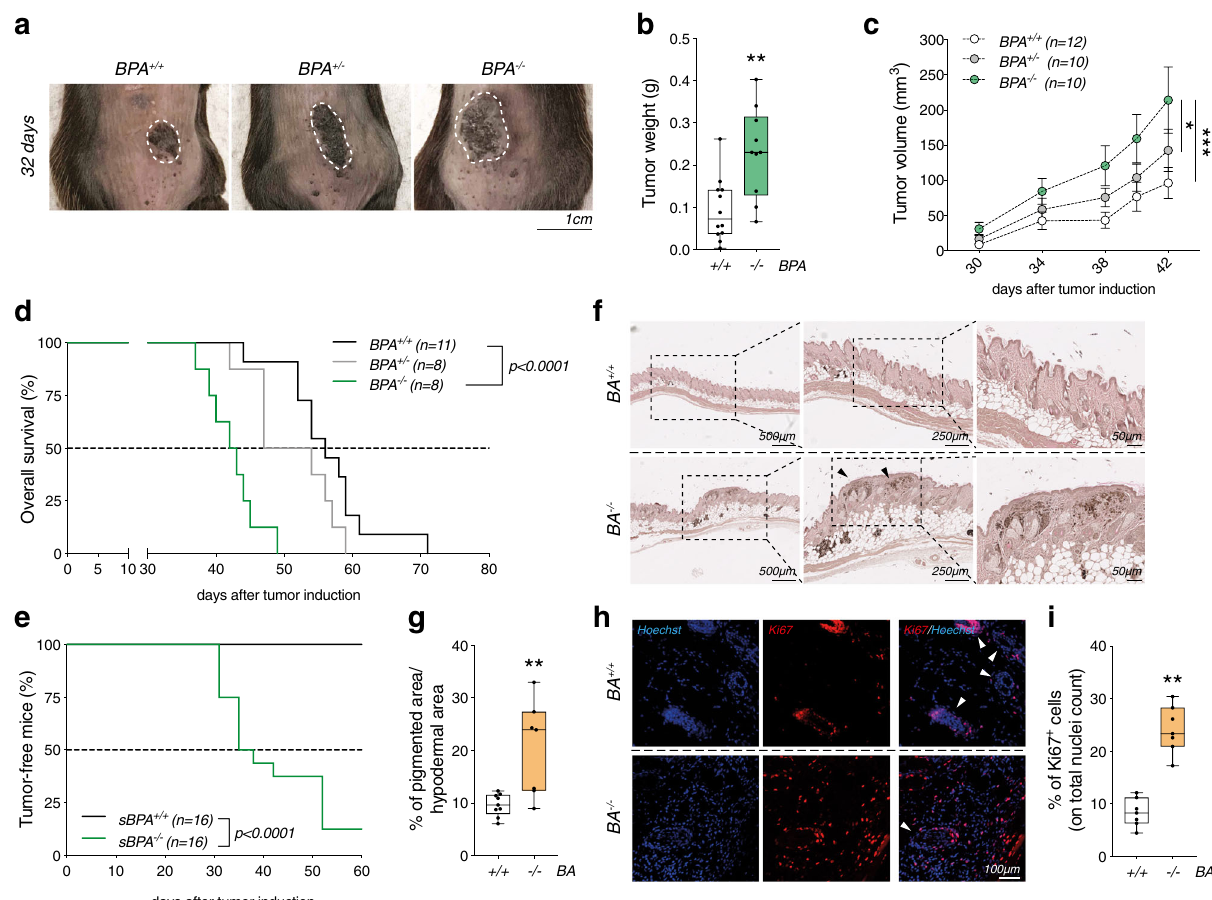
Fig. 1 Ambra1 deletion promotes melanoma development in Braf V600E/ + ;Pten − / − mice. a Representative pictures of tumors from BPA + / + , BPA + / − and BPA − / − mice at 32 days after treatment. b Weight of BPA + / + ( n = 12) and BPA − / − ( n = 10) tumors at endpoint (42 days) (** p = 0.0053, two-tailed unpaired t -test, BPA − / − vs. BPA + / + ). c Kinetics of tumor growth in BPA + / + ( n = 12), BPA + / − ( n = 10) and BPA − / − ( n = 10) mice. Each data point corresponds to the average tumor volume ± SEM for each experimental group ( *p = 0.0128; ***p = 0.001, one-way ANOVA). d Kaplan – Meier overall survival curves of BPA + / + ( n = 11), BPA + / − ( n = 8) and BPA − / − ( n = 8) mice ( p < 0.0001 , Two-sided log-rank test, BPA − / − vs. BPA + / + ) and e of mice subcutaneously injected with 2×10 6 BPA + / + - ( sBPA + / + ; n = 16) or BPA − / − - ( sBPA − / − ; n = 16) tumor-derived cells. Tumors appearance was monitored for 60 days ( p < 0.0001 , Two-sided log-rank test, sBPA − / − vs. sBPA + / + ). f Areas of hyperplasia (black arrows) and of pigmentation in skin sections of BA + / + ( n = 9) and BA − / − ( n = 7) mice are shown and g quanti fi ed. Each data point represents one mouse and corresponds to the average percentage ± SEM of the pigmented area (at least four regions analyzed for each mouse) ( **p = 0.0033, two-tailed unpaired t -test, BA − / − vs . BA + / + ). h Representative images of Ki67 immunostaining (red) in skin sections of BA + / + ( n = 7) and BA − / − ( n = 7) mice. Nuclei are shown in blue (Hoechst). White arrows indicate hair bulbs. i Quanti fi cation of the signal shown in h . Each data point represents one mouse and corresponds to the average ratio ± SEM of Ki67 + cells on the nuclei count (at least three fi elds analyzed for each mouse) ( **p = 0.006, two-tailed unpaired t -test, BA − / − vs. BA + / + ). Box-and-whisker plots shown in ( b , g , i ) represent values from minimum to maximum. Top and bottom whiskers denote upper (Q 3 ) and lower (Q 1 ) quartiles, respectively. Boxes refer to interquartile ranges. Medians are denoted as horizontal line in the middle of the